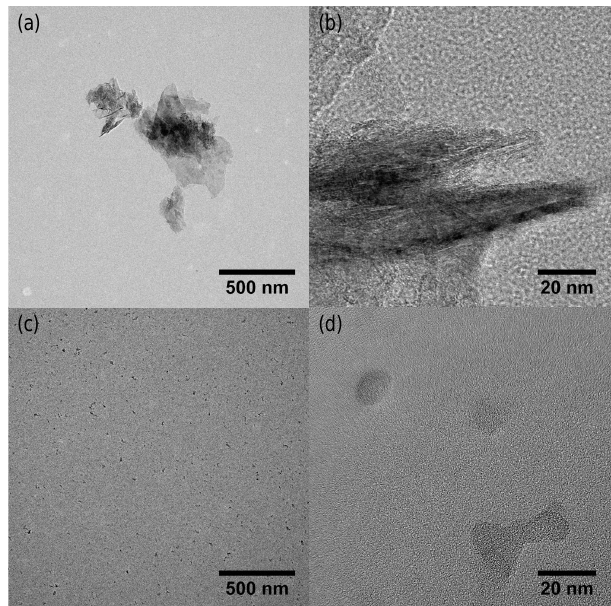
Figure 5. TEM images of Aqudag ® with the SP2 laser off (a, b) and on (c, d) . The higher-resolution images show that the new particles do not exhibit structural motifs indicative of graphitic carbon. Thus, the new particles are likely formed from homogeneous nucleation of rBC vapors instead of fragments of the original